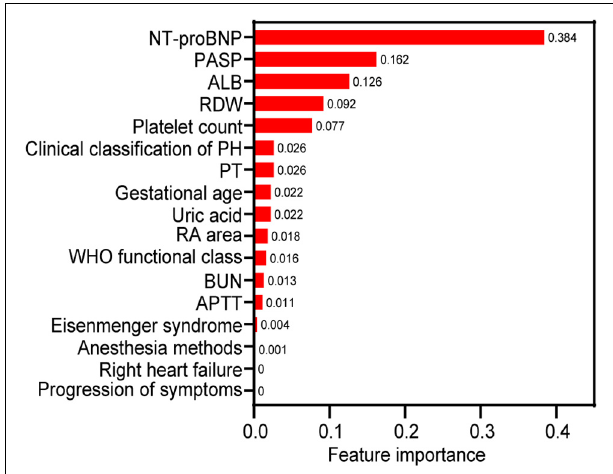
FIGURE 2 | The relative feature importance of predictor variables included in the gradient boosting decision tree for predicting the death of pregnant women with pulmonary hypertension. NT-proBNP, N-terminal brain natriuretic peptide; PASP, pulmonary artery systolic pressure; ALB, albumin; RA, right